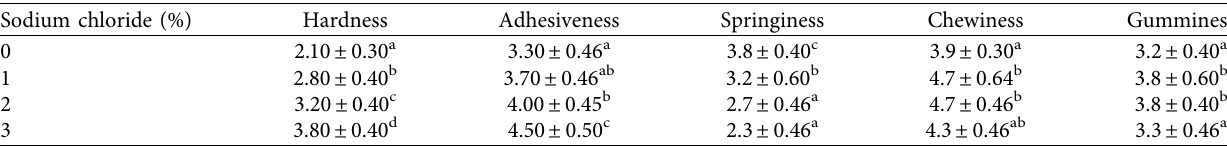
Table 3: Sensory indexes (mean ± SD) of M. salmoides products with different sodium chloride concentrations. Sodium chloride